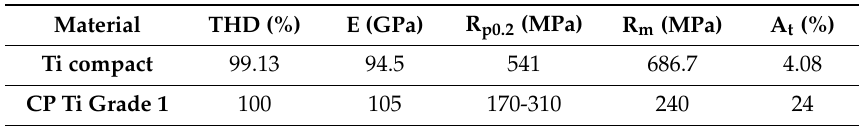
Table 1. Mechanical properties of the low temperature PM processed titanium compacts compared with the properties of the CP Ti Grade 1